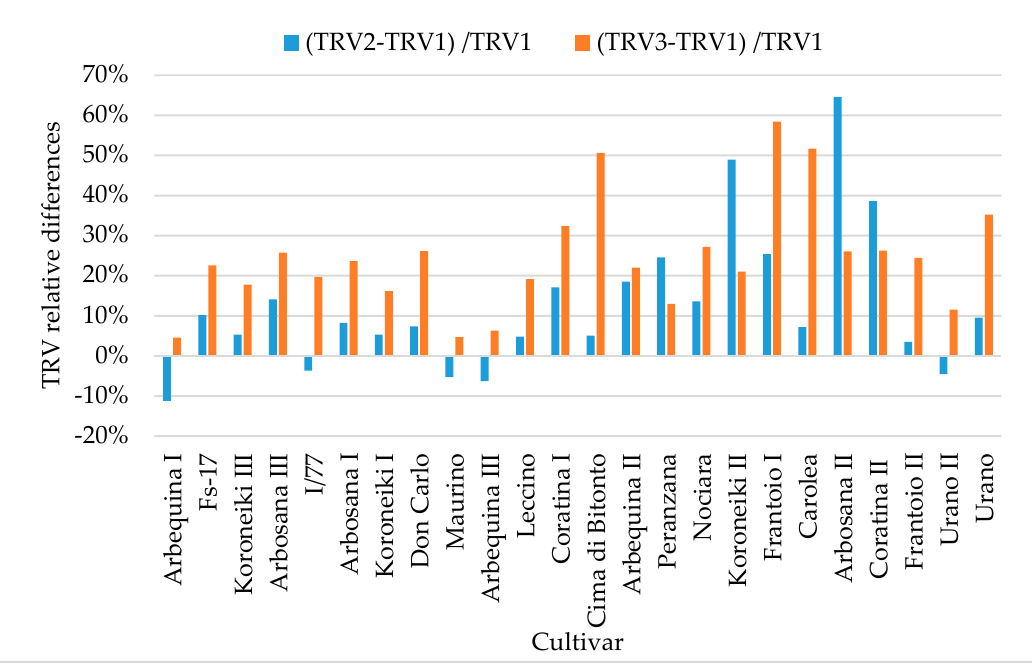
Figure 12. Differences between the absolute values measured by the three TRVs per row. Figure 12. Di ff erences between the absolute values measured by the three TRVs per